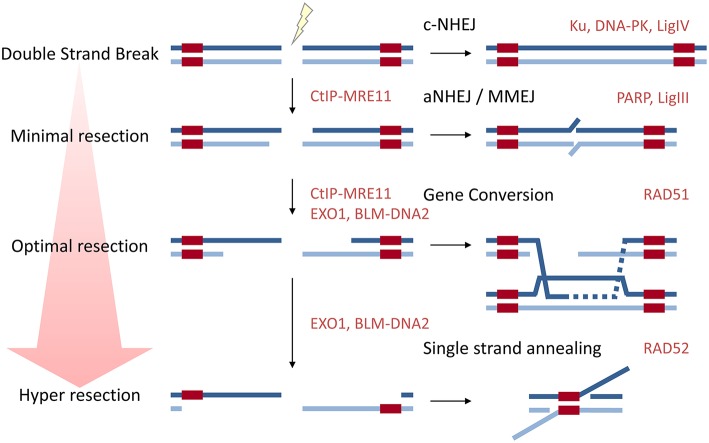
A diagram to show how resection influences repair pathway choice. Approximately 80% of DSBs are repaired by classical NHEJ which does not require resection. aNHEJ or MMEJ requires minimal resection to expose regions of microhomology. Long range resection is required for the major HDR pathways gene conversion (GC) and single-strand annealing (SSA). Key proteins in each pathway are given in red.